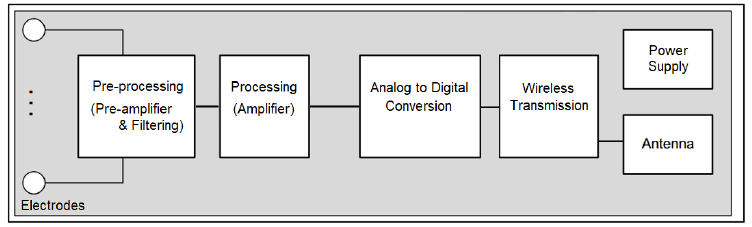
Figure 1. General EMG acquisition